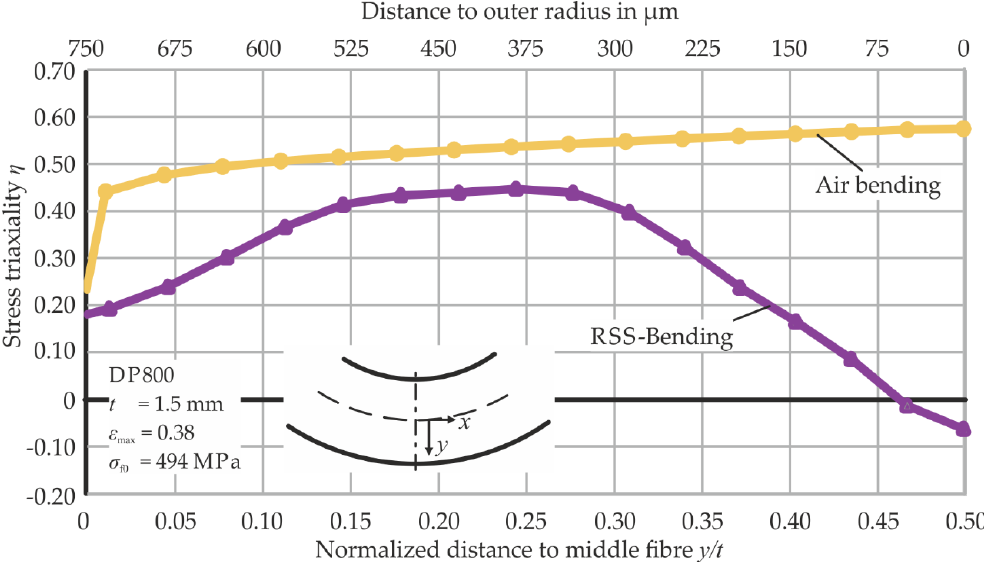
Figure 15. Triaxiality distribution in air bending and RSS bending during maximum stress superposition in the outer fibers.